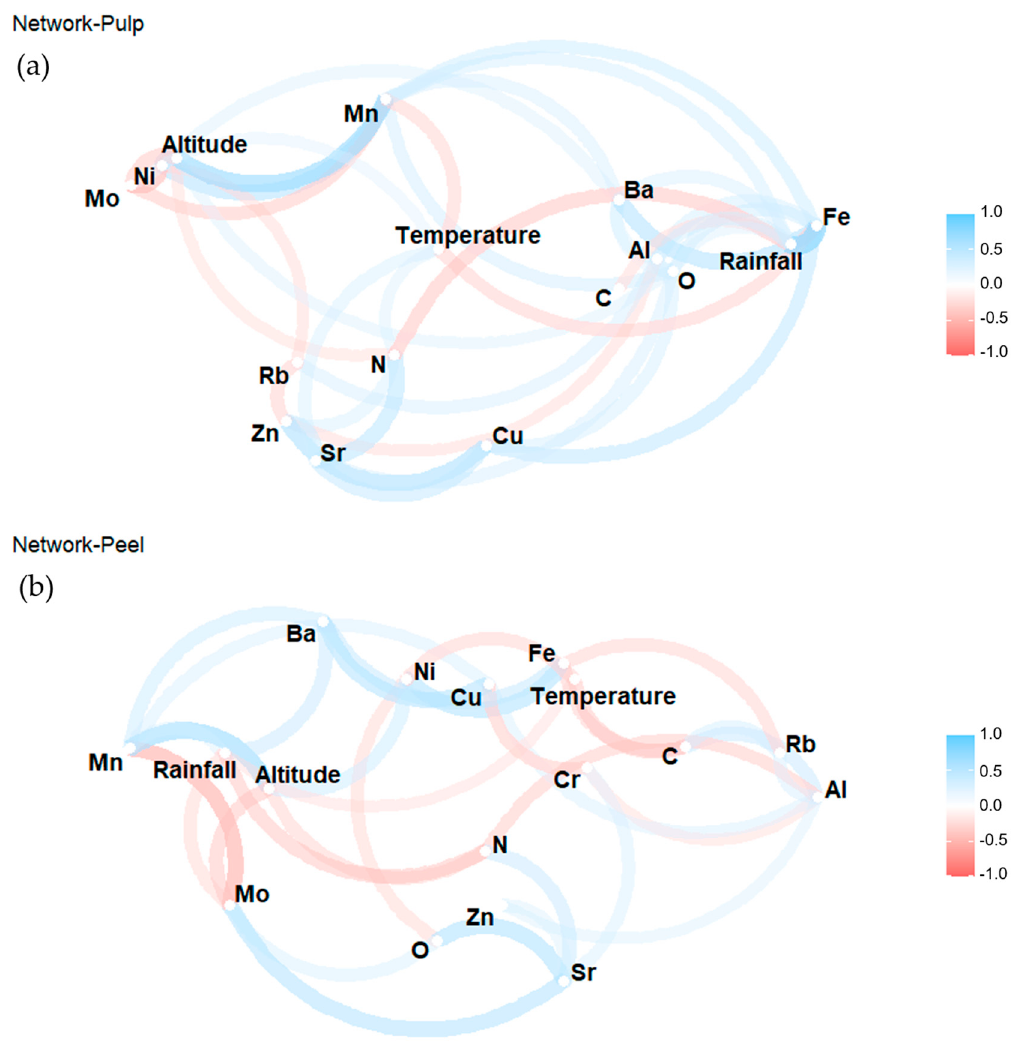
Figure 4. The correlation network of stable isotopes, elements and growing conditions of banana pulp ( a ) and peel ( b ) (refer to the web version of this article for the interpretation of the colors used in the figure.).